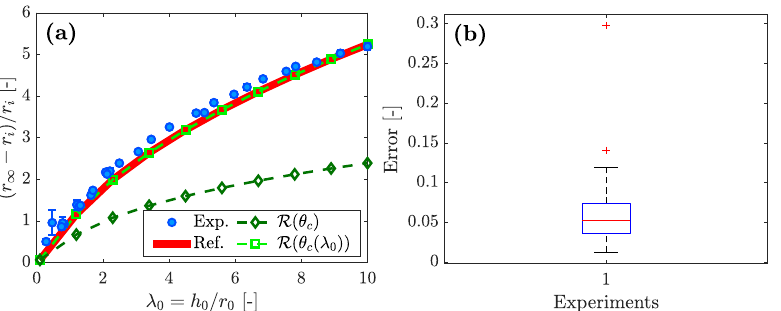
Figure 7. ( a ) Normalised final run-out distances ( r ∞ − r 0 ) / r 0 with respect to the initial aspect ratio λ 0 = h 0 / r 0 , with the non-dimensional unit symbol (-). The proposed analytical solution g ( θ c ) (dark green line) predicts lower normalised run-out distances when considering a quasistatic deformation of the column. When relating λ 0 to θ c , the solution (green line) is in agreement with both the experimental results (blue circles) and the solution proposed by [27] (thick red line). The ( b ) box plot of the errors for the experimental data demonstrates a rather skewed distribution of errors with a few outliers (red crosses). This explains the overall small amplitude of the error bars in ( a ). In this case, θ c = φ y was considered, where the internal yield angle was φ y = tan − 1 ( µ ) with µ = 0.77. The latter was inferred with the experimental protocol previously